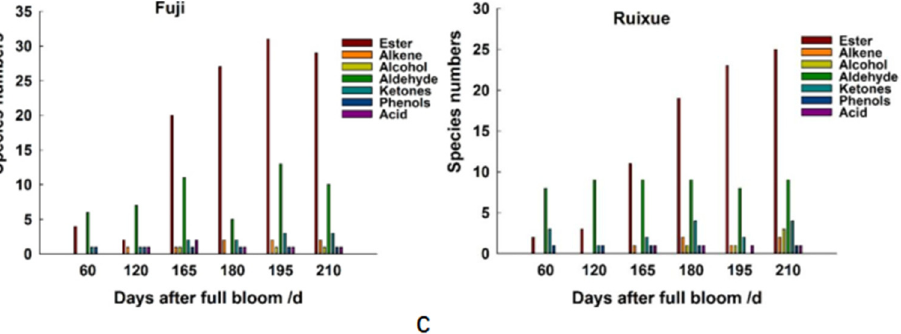
Figure 2. Volatile compounds in “Ruixue” and “Fuji” apples at different stages of fruit development. ( A ) Total volatile content; ( B ) Volatile compound relative content; ( C ) Volatile compound species numbers. Table 1. Major volatile compounds detected in “Ruixue” apple fruit during different developmental stages (DAFB, days after full